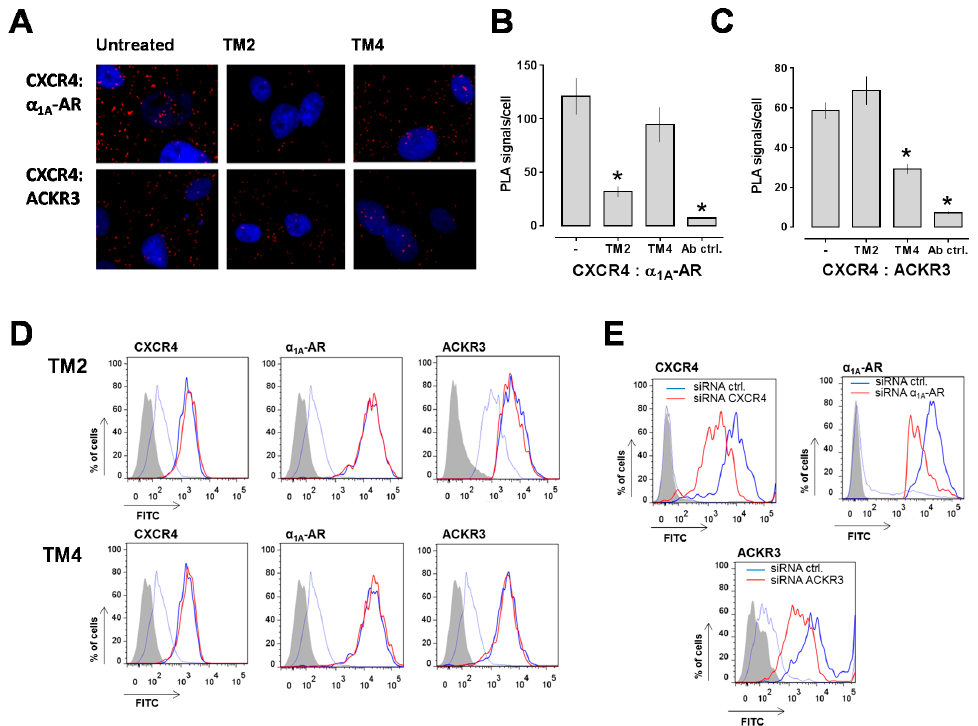
Figure 1. ( A ) Interactions between CXCR4 and α 1A -AR ( top ) and between CXCR4 and ACKR3 ( bottom ) were visualized by PLA. Images show merged PLA/4 ′ ,6-diamidino-2-phenylindole dihydrochloride (DAPI) signals and are representative of 3 independent experiments. hVSMC were incubated with or without TM peptides (100 μ M, 15 min at room temperature) prior to PLA; ( B ) Quantification of the number of PLA signals per cell for CXCR4: α 1A -AR interactions as in A. Ab ctrl.: Antibody control; the primary antibodies were omitted. n = 3 (10 randomly selected non-overlapping vision fields were analyzed per experiment). *: p < 0.05 vs. untreated cells; ( C ) Quantification of the number of PLA signals per cell for CXCR4:ACKR3 interactions as in A. Ab ctrl.: Antibody control; the primary antibodies were omitted. n = 3 (10 randomly selected non-overlapping vision fields were analyzed per experiment). *: p < 0.05 vs. untreated cells; ( D ) FACS analyses of receptor cell surface expression levels in hVSMC after incubation with the TM peptides (100 μ M, 15 min at room temperature). Grey: Unstained cells; Thin blue line: IgG control; Thick blue line: Cells incubated without TM peptides; Thick red line: Cells incubated with TM peptides; FITC: Fluorescein isothiocyanate; ( E ) FACS analyses of receptor cell surface expression after incubation hVSMC with non-targeting siRNA (thick blue line) or siRNA specific for each receptor (thick red line). Grey: Unstained cells; Thin blue line: IgG control.